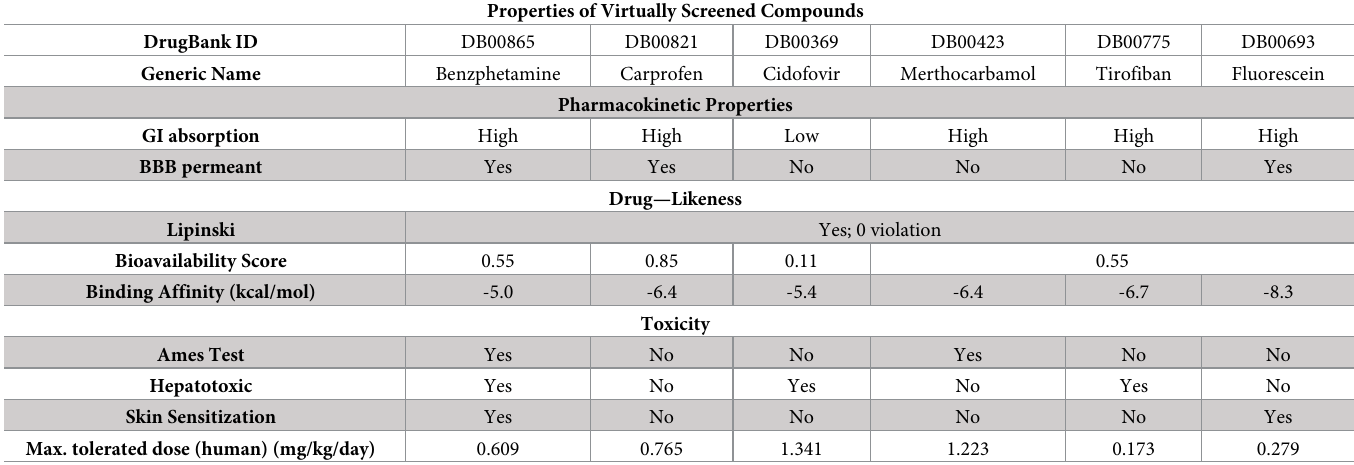
Table 7. Properties of six shortlisted compounds from the approved